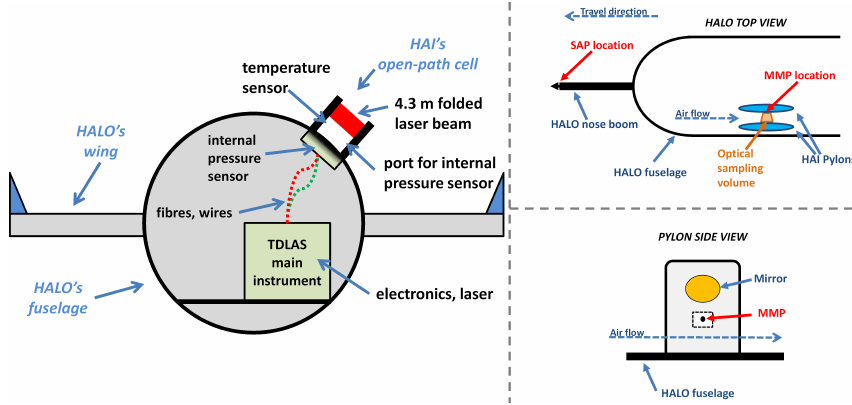
Figure 6. Schematics of the HAI open-path sensor installed on the HALO research aircraft fuselage. The open-path cell itself comprises two platinum PT100 sensors for air temperature measurements for use in data evaluation. Our HAI pressure measurement interface port allows for comparison between the “spectroscopically determined” pressure and a standard pressure transmitter (MMP). Additionally, several pressure sensors are installed in the nose boom of the HALO aircraft to measure the static ambient pressure (SAP).